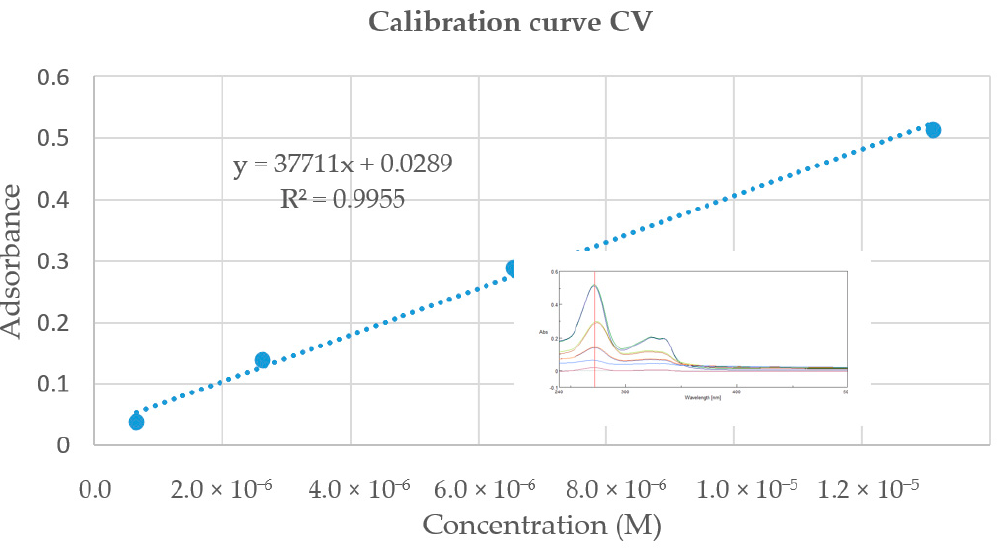
Figure 20. Calibration curve CP at 280 nm, absorbance versus concentration.